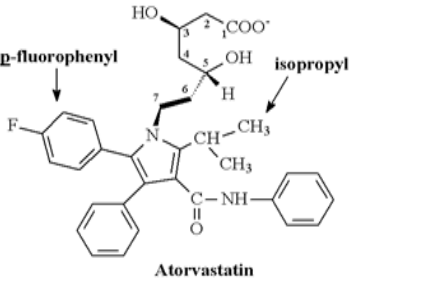
Figure 1. Chemical structure of atorvastatin calcium (11)